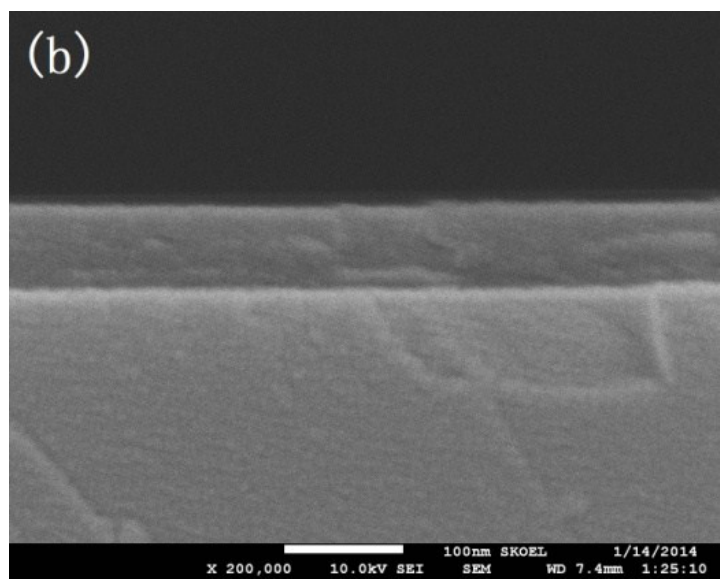
Figure 2. Cross-section SEM images of Al 2 O 3 : ( a ) 80 °C-based Al 2 O 3 ; ( b ) 200 °C-based Al 2 O 3 .